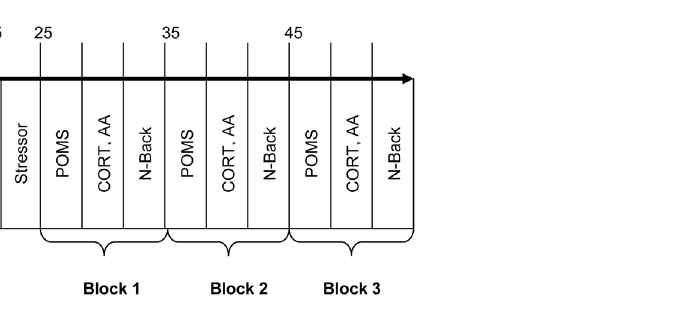
Fig. 2 for schematic of procedure).